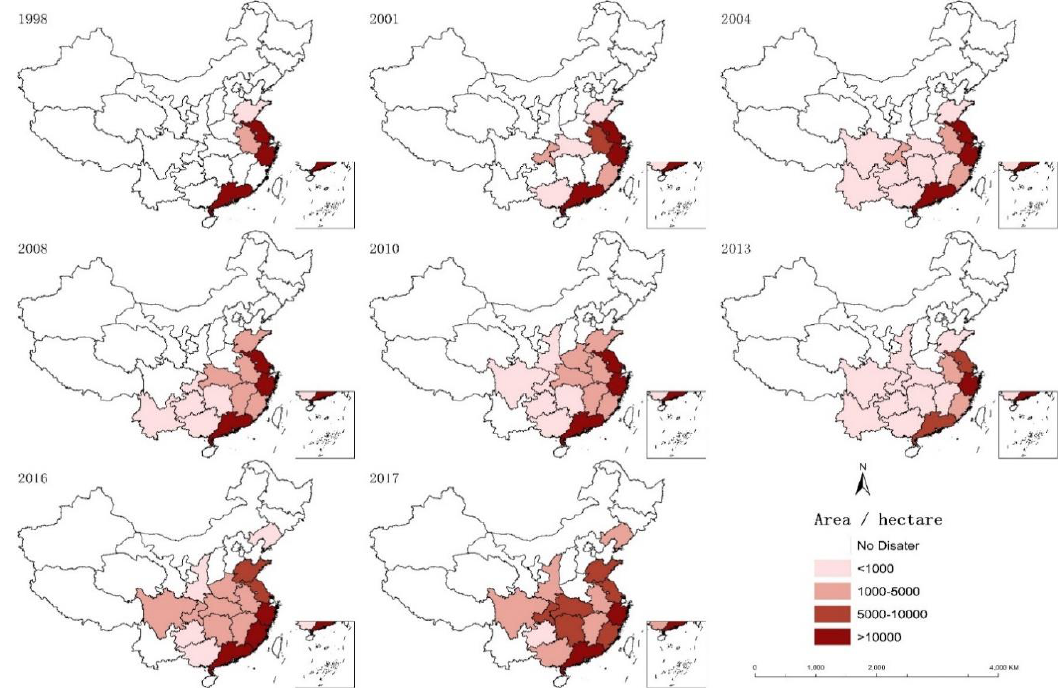
Figure 2. The area of pine wood nematode disease in the province level of mainland China from 1998 Figure 2. to 2017.